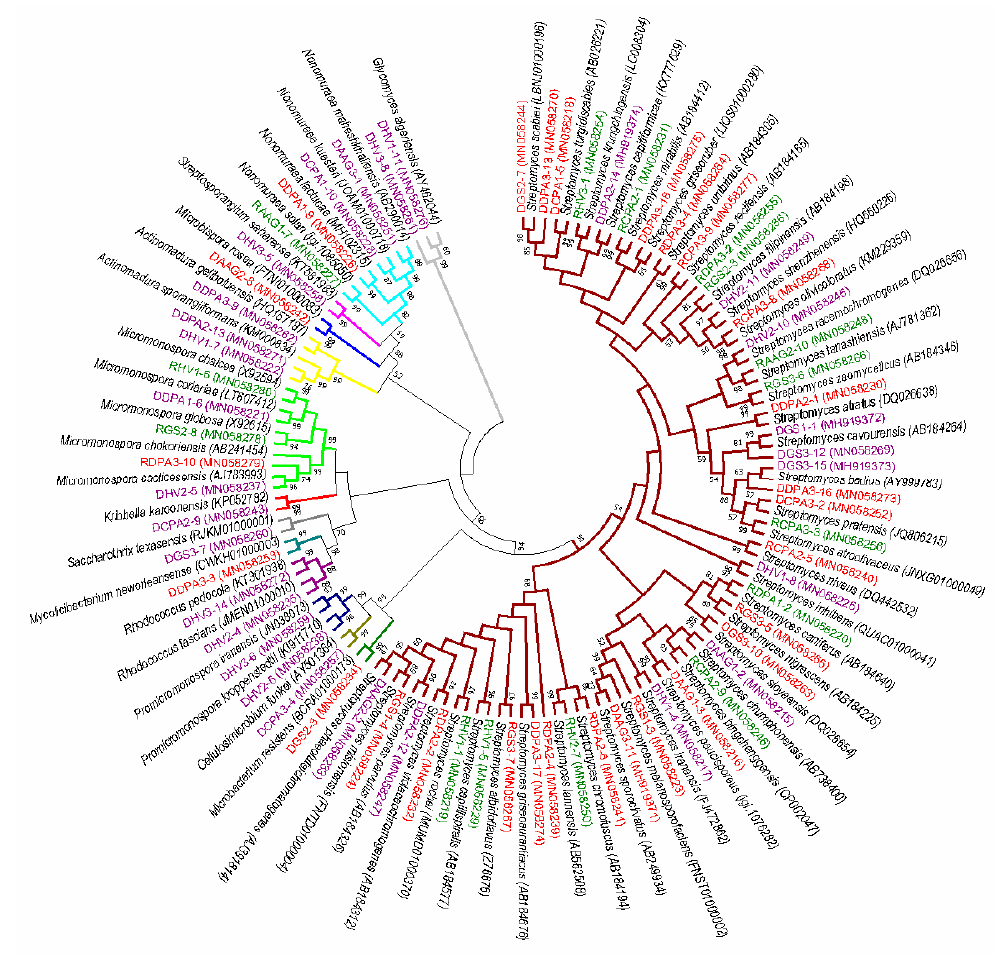
Figure 1. Neighbor-joining phylogenetic tree of 16S rRNA gene sequences from 70 endophytic actinobacteria in this study and their phylogenetic neighbors. Numbers at nodes are bootstrap values (percentages of 1000 replications); only values > 50% are shown. GenBank accession numbers of 16S rRNA gene sequences are shown next to isolate names. A branch indicated by the same color belongs to the same genus. Isolates indicated by green and purple are endemic to the healthy and diseased samples, respectively. Isolates shared by healthy and diseased samples are indicated with red. Microorganisms 2019 , 7 , x FOR PEER REVIEW